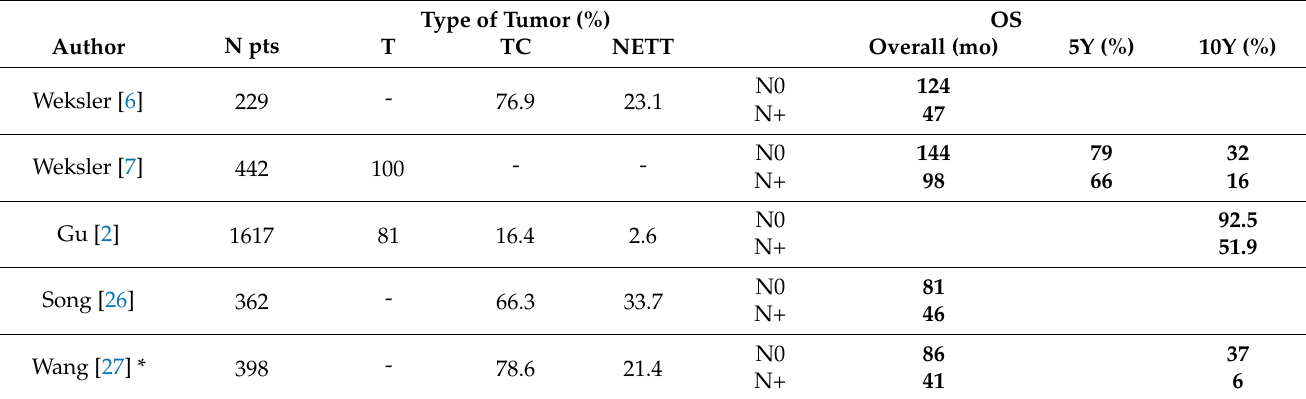
Table 2. Studies comparing survival rates in N0 vs. N+ patients over the last 20 years. Difference of values in bold is statistically